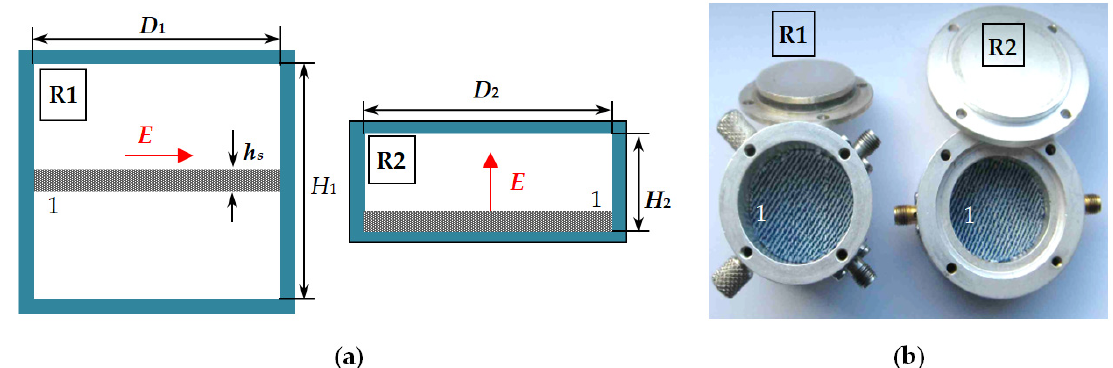
Figure 1. Two-resonator method: ( a ) Pair of resonators for measurement of parallel (R1) and perpendicular (R2) dielectric parameters of disk samples in cylindrical TE (R1) and TM-mode (R2) resonators; ( b ) Photography of resonators R1 and R2 with denim textile sample 1; E—electric field.